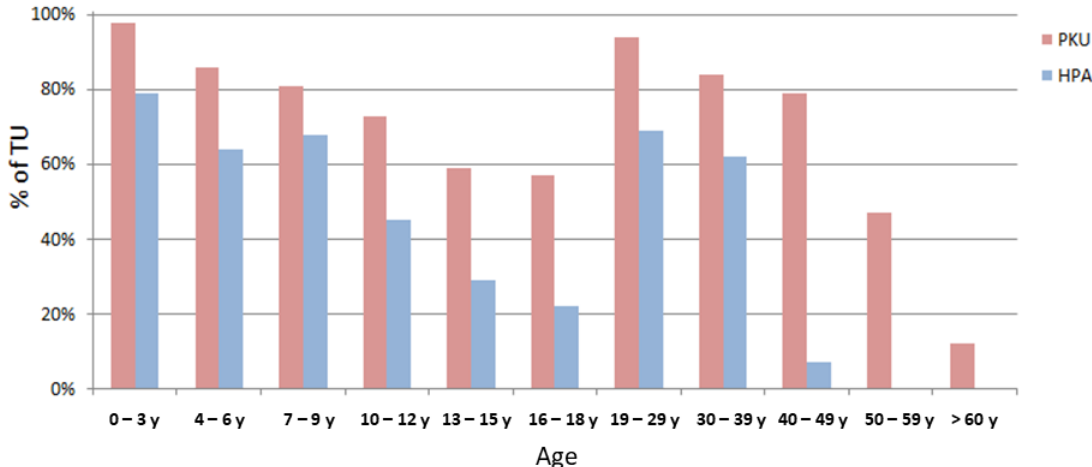
Figure 4. Percentages of telehealth use among PKUs and HPAs based on age (the “age” field indicates the age of the patient even in the case of underage patients, where the parent is the real interlocutor as required by legal regulations).